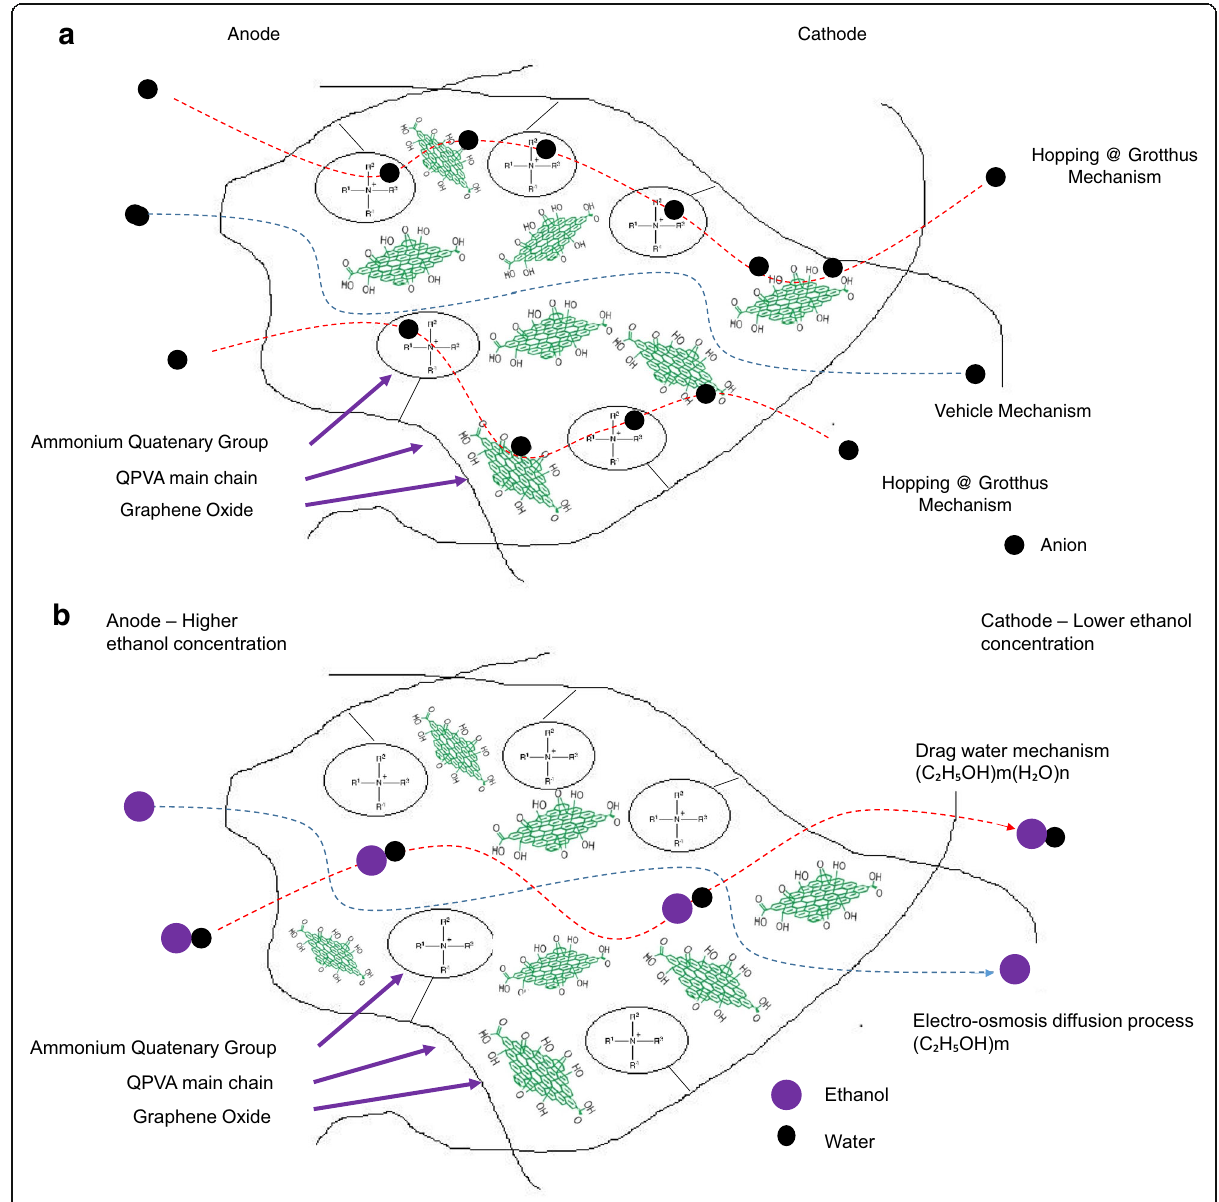
Fig. 10 a Illustration of ionic transfer for the crosslinked QPVA/GO composite membrane. b Illustration of ethanol transfer for the crosslinked QPVA/GO composite